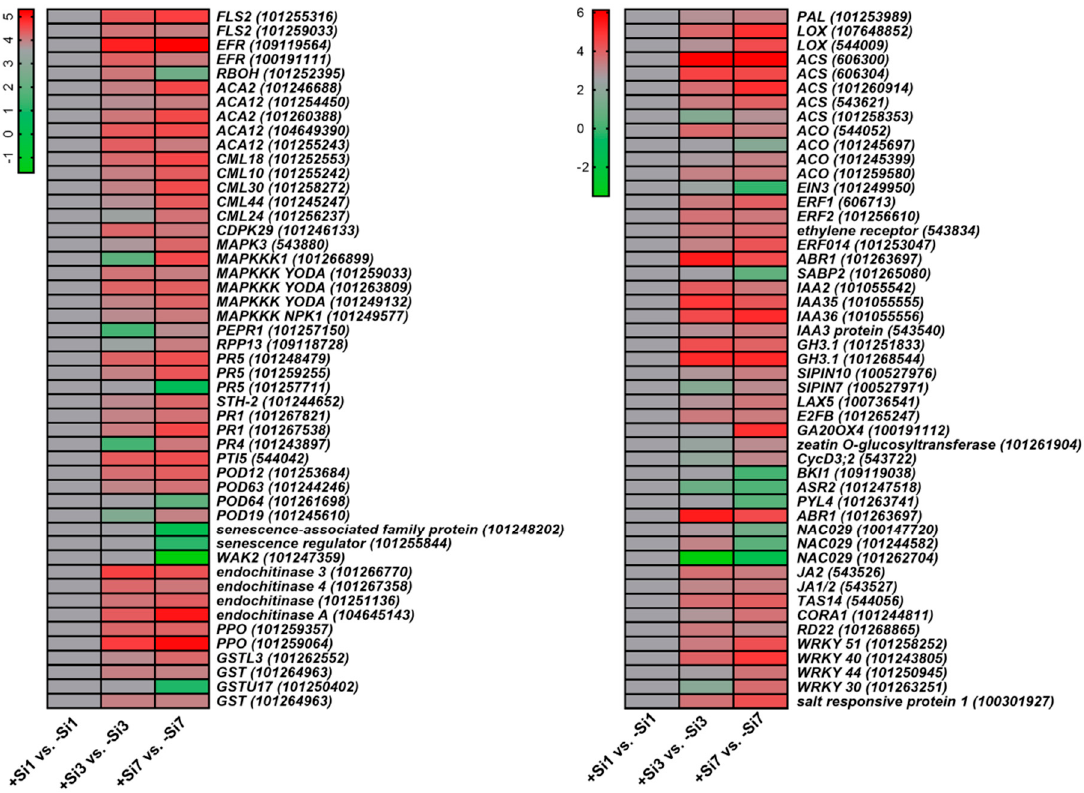
Figure 6. Heat map of DEGs potentially associated with silicon (Si)-mediated tomato resistance against R. solanacearum . The columns represent the pairwise comparisons of Si-treated samples (+Si) and their respective non-Si-treated samples ( − Si) at three time points post-inoculation. +Si1, +Si3, and +Si7 represent Si-treated samples obtained at 1, 3, and 7dpi, respectively; − Si1, − Si3, and − Si7 represent non-Si-treated samples obtained at 1, 3, and 7dpi, respectively. Relative transcript level was indicated on a color scale from magenta (high) to green (low). DEGs names are on the right side of the figure. Details of the genes shown in heat maps are available in Table S10.